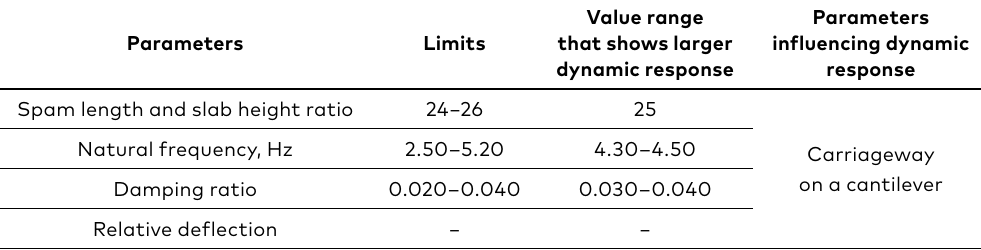
Table 3. Values which indicate increased dynamic